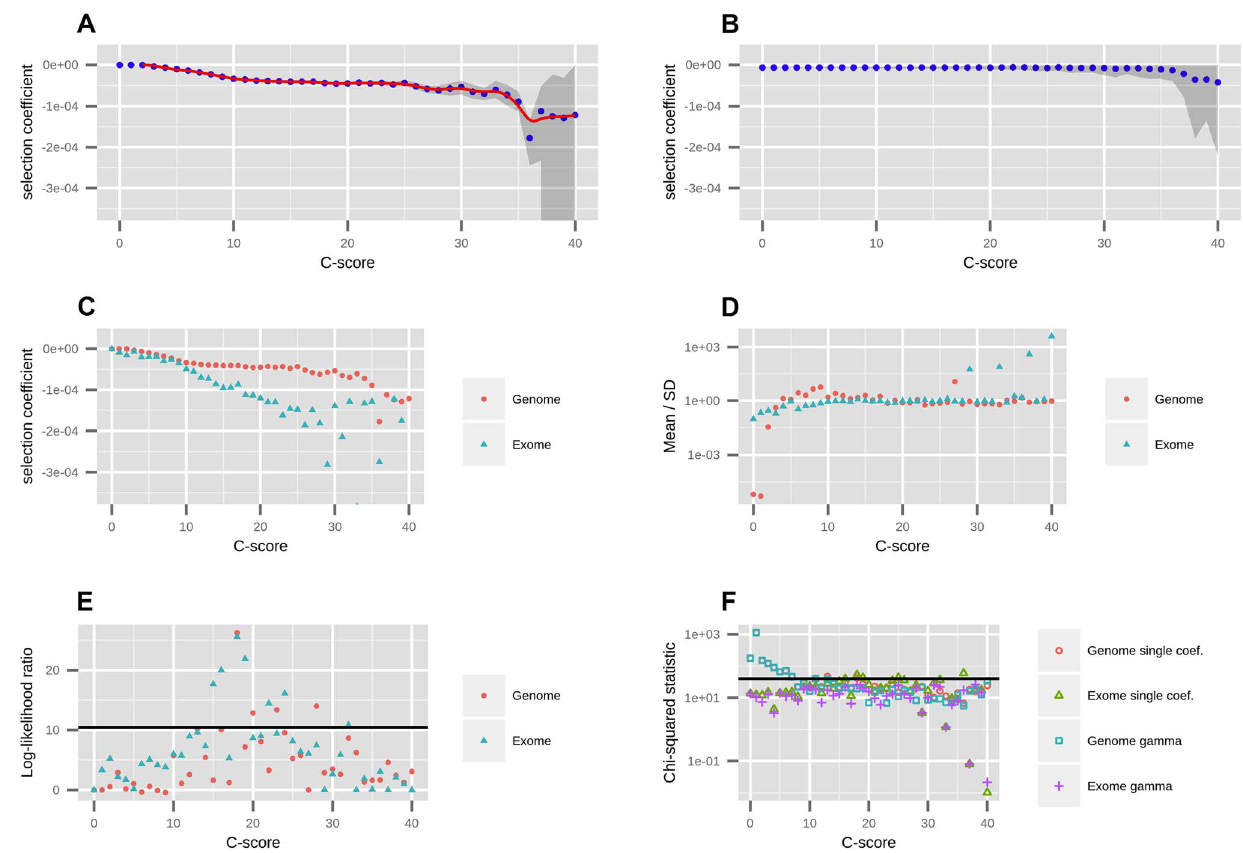
Figure 1. Mapping of C-scores to selection coefficients. A) We first fit a single coefficient to each bin using data from all autosomes in the genome. Red dots represent the maximum likelihood selection coefficient corresponding to each C-score bin. The blue line is a smooth spline fitted to the discrete mappings of C-scores to log-scaled selection coefficients after excluding the neutral bins (degrees of freedom =20). The grey shade is a 95% confidence interval obtained from bootstrapping the data 100 times in each bin. B) To verify the shape of the mapping was not a result of the number of sites in each bin, we randomized the C-score labels across polymorphisms, and recomputed the mapping. C) To account for exonic patterns of conservation and background selection that may not have been captured by C-scores, we computed a mapping based solely on exonic sites. D) We fitted gamma distributions of selection coefficients to each bin, and computed the mean divided by the standard deviation of each distribution, which is indicative of its shape (see Results). E) To test whether the gamma distributions were a significantly better fit than the single- coefficient mapping, we computed log-likelihood ratio statistics of the two models at each bin. The black line denotes the Bonferroni-corrected significance cutoff. F) To test how well we were fitting the data at each bin, we computed chi-squared statistics of the fitted SFS to the observed SFS at each bin. The black line denotes the Bonferroni-corrected significance cutoff.